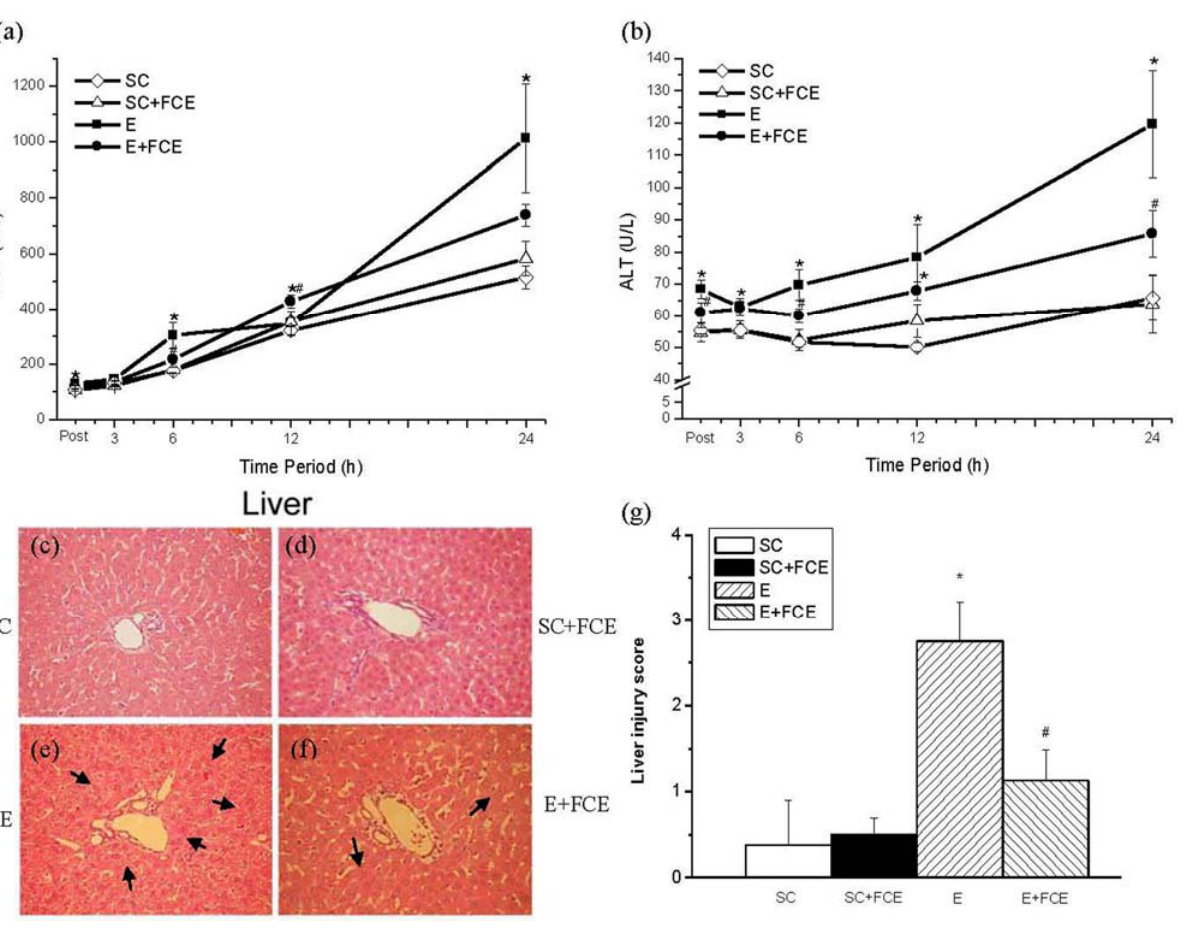
Figure 3. Assessment of the liver injury induced by intense exercise in rats. Measurement of plasma AST ( a ) and ALT ( b ) levels in experimental rats at post, 3, 6, 12, and 24 h after exercise. Values are the means ± S.E.M.; n = 8, * p < 0.05, compared to the SC group; # p < 0.05, compared to the E group. Histologic sections from the liver ( c – f ) were stained with hematoxylin and eosin (H & E) to observe the tissue morphology infiltration (liver: original magnification 200×). Histopathologic injury score in the liver ( g ) after an acute bout of exhaustive exercise at 24 h in rats. * p <